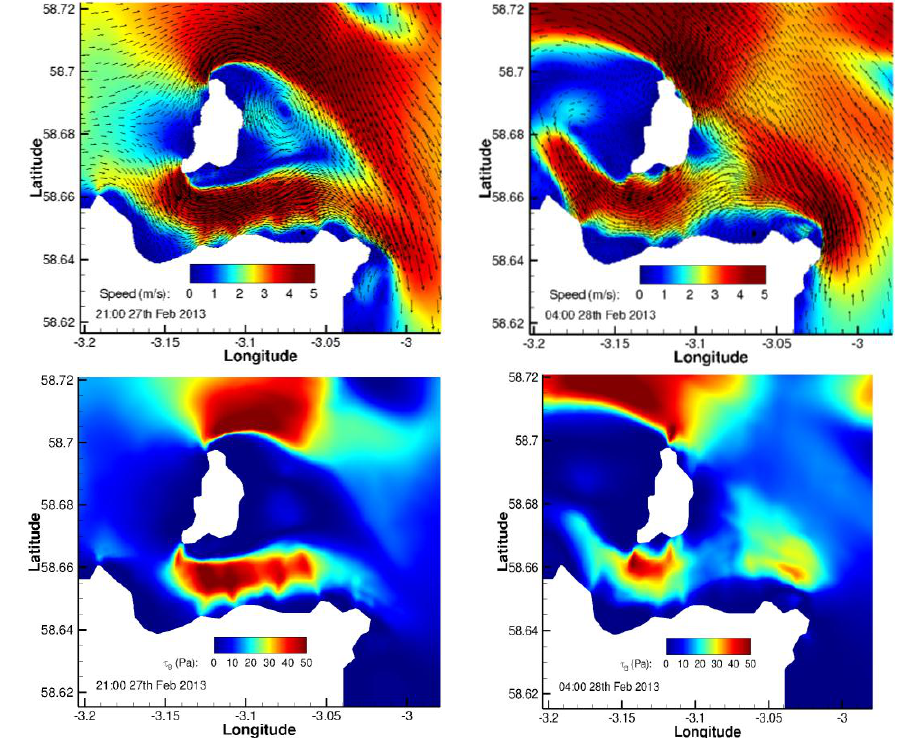
Figure 11. Model-predicted depth-averaged currents on a spring flood ( top left ) and spring ebb ( top right ) on 27–28 February 2013. Current vectors (m s −1 ) are overlain on the coloured current speed (m s −1 ). The bed shear stress (Pa) for the corresponding flood ( bottom left ) and ebb ( bottom right ) tides are calculated using Equation (1). Table 2. Modelled and observed amplitude (m s −1 ) and phase (°) of the tidal velocities for the principal tidal constituents.